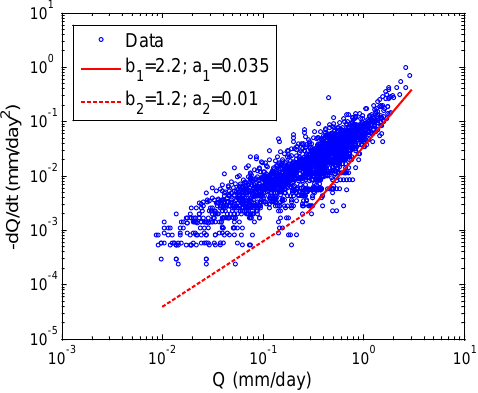
Fig. 1. − d Q /d t versus Q and the lower envelope for the Spoon Fig. 1. -d Q /d t versus Q and the lower envelope for the Spoon River watershed based on daily River watershed based on daily streamflow data for the period of 1 January 1983–31 December streamflow data for the period of 01/01/1983-12/31/2003.